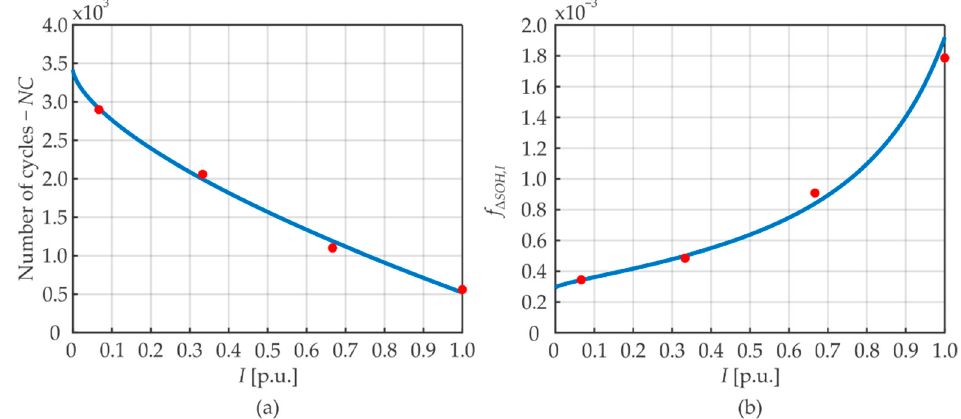
Figure 3. Influence of the normalized battery current: ( a ) number of cycles and ( b ) f Δ SOH,I . Table 1. Values for tuning coefficients of models of lithium-ion degradation impact factors.